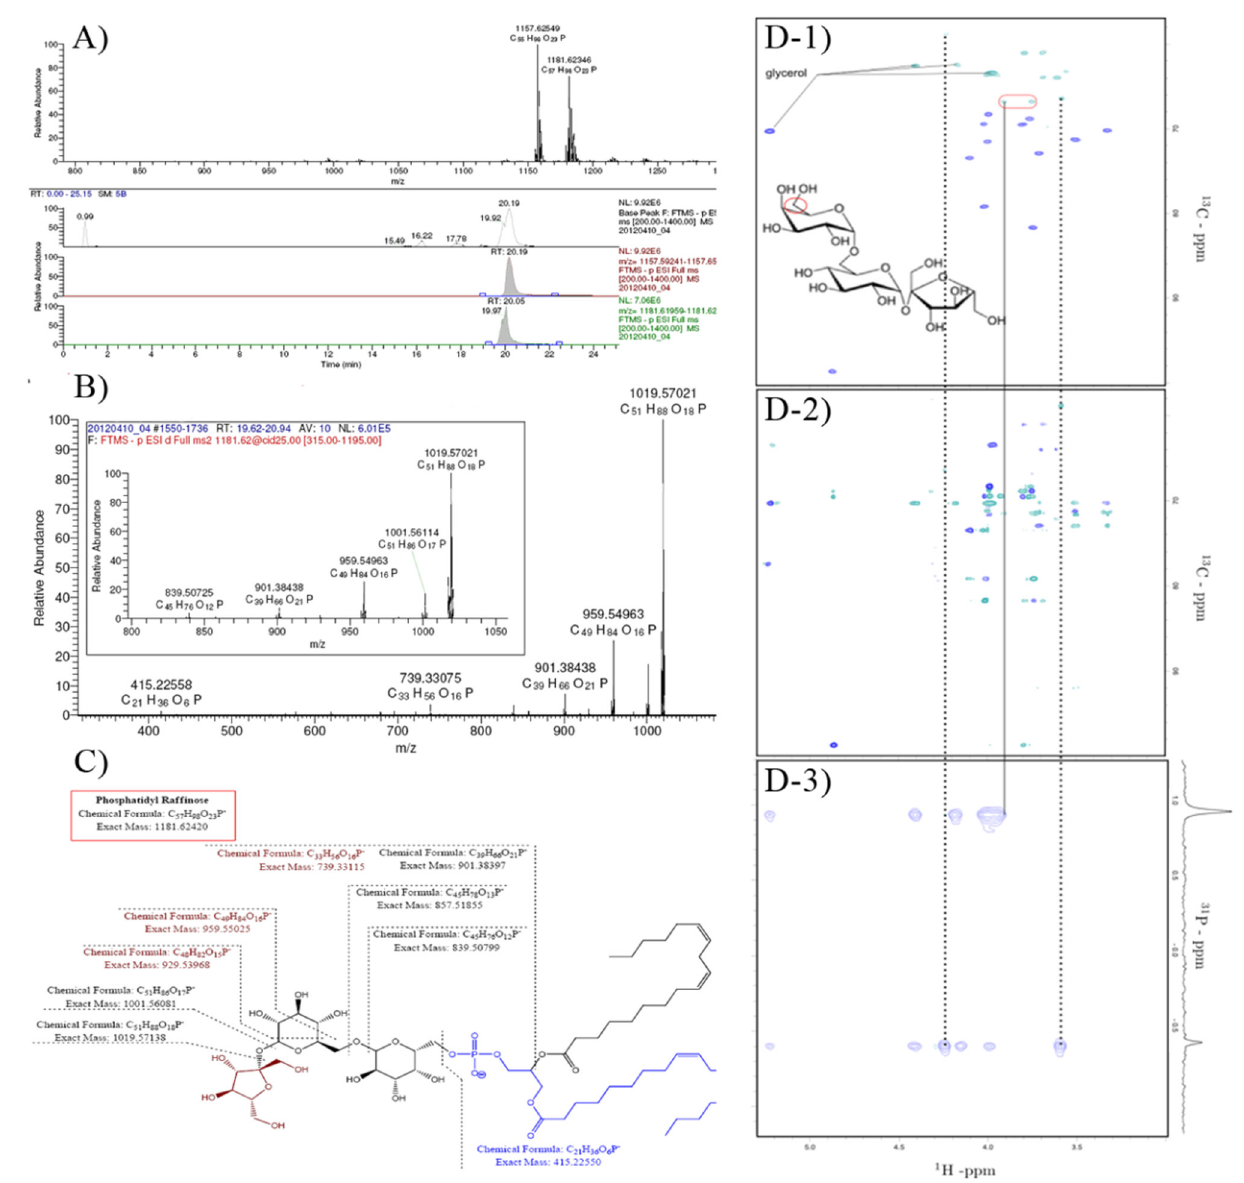
Figure 2. Structural elucidation of Ptd-Raff. A) Base-peak and extracted ion chromatograms and full FTMS spectrum of Ptd- Raff. The two major isomers are m/z 1181 [18:2, 18:2] and m/z 1157 [18:2, 16: 0]. B) MS 2 spectra of the two major isomers. The primary fragments are explained in C). C) Chemical structure of Ptd-Raff. D-1) multiplicity edited 13 C- 1 H HSQC, D-2)